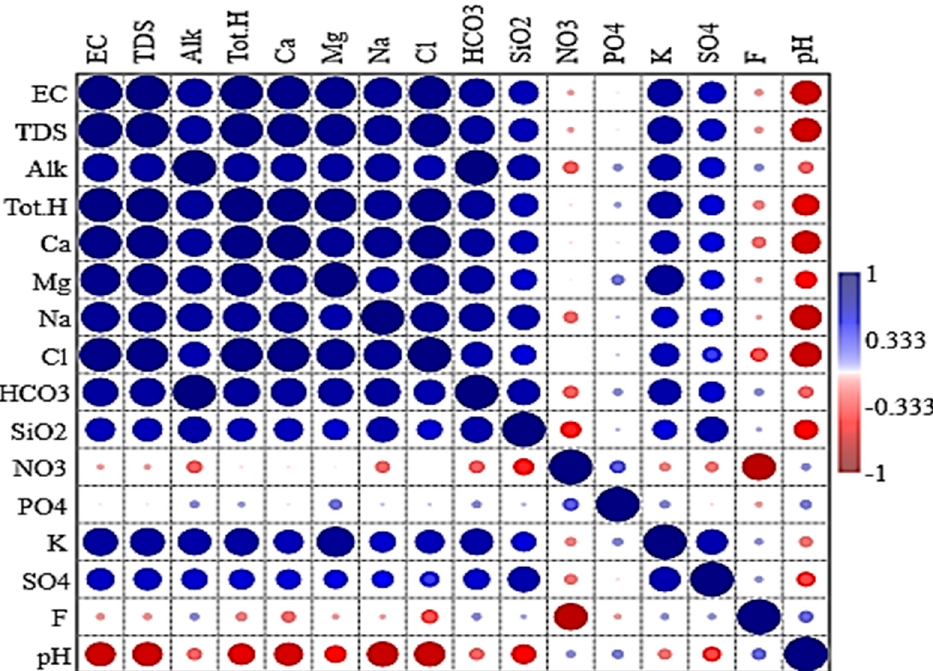
Figure 9. Pearson’s correlation matrix for the physicochemical parameters.